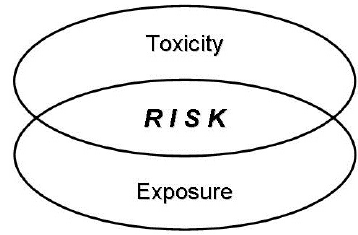
Figure 1. Risk is a combination of toxicity and exposure.